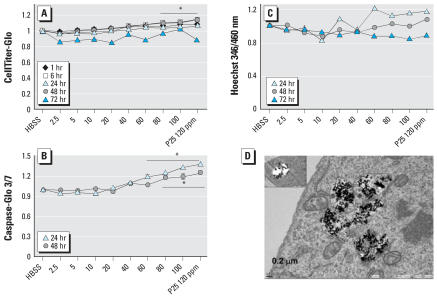
(A) N27 neurons were exposed (1–72 hr) to P25 (2.5–120 ppm) and intracellular ATP levels measured with CellTiter-Glo. Significant increases were seen as early as 1 hr postexposure to ≥80 ppm and continued until 48 hr in response to ≥40 ppm. (B) Significant increases (p < 0.05) in caspase 3/7 activity were first seen in N27 neurons after 24 hr in response to ≥40 ppm P25. (C) Significant reductions of Hoechst stain did not occur in response to P25 (2.5–120 ppm) at any time point. (D) TEM of P25 (20 ppm, 3 hr) treated N27 neurons showed numerous membrane-bound aggregates. An amorphous substance was seen within the vacuoles (insert). In addition, individual nanosize P25 particles (circle) were noted throughout the cytoplasm. Mitochondria in nearby proximity showed no evidence of disruption or swelling.